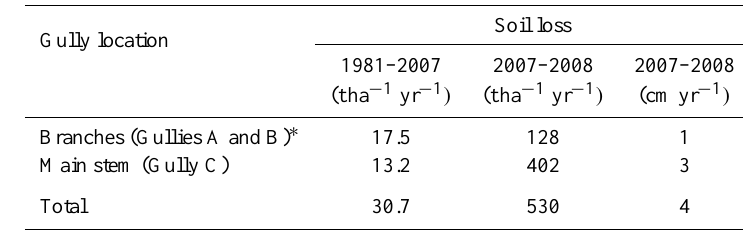
Table 1. Gully erosion losses calculated with Eqs. (1) and (2) for the sum of gullies A and B and gully C. Erosion rates calculated from the gullies are then distributed uniformly over the contributing area.